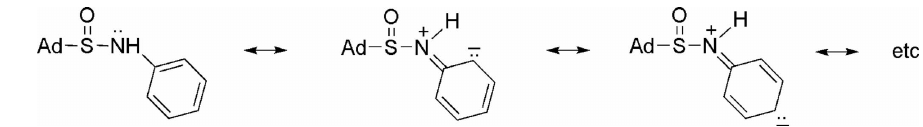
Figure 1 Molecular structure of (I), with atom labels and 50% probability displacement ellipsoids for non-H atoms.